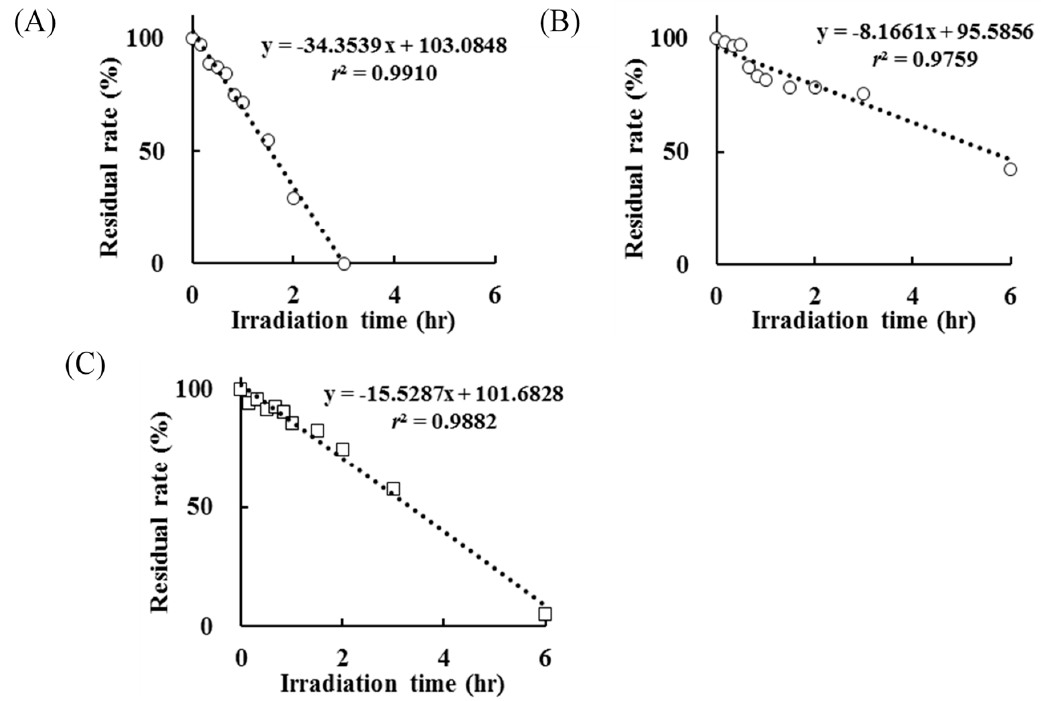
Figure 3. Residual rate of ( A ) NX in the absence of L-ascorbic acid (AA), ( B ) NX in the presence of AA at 1 mmol/L and ( C ) AA after UV irradiation for up to 6 h.